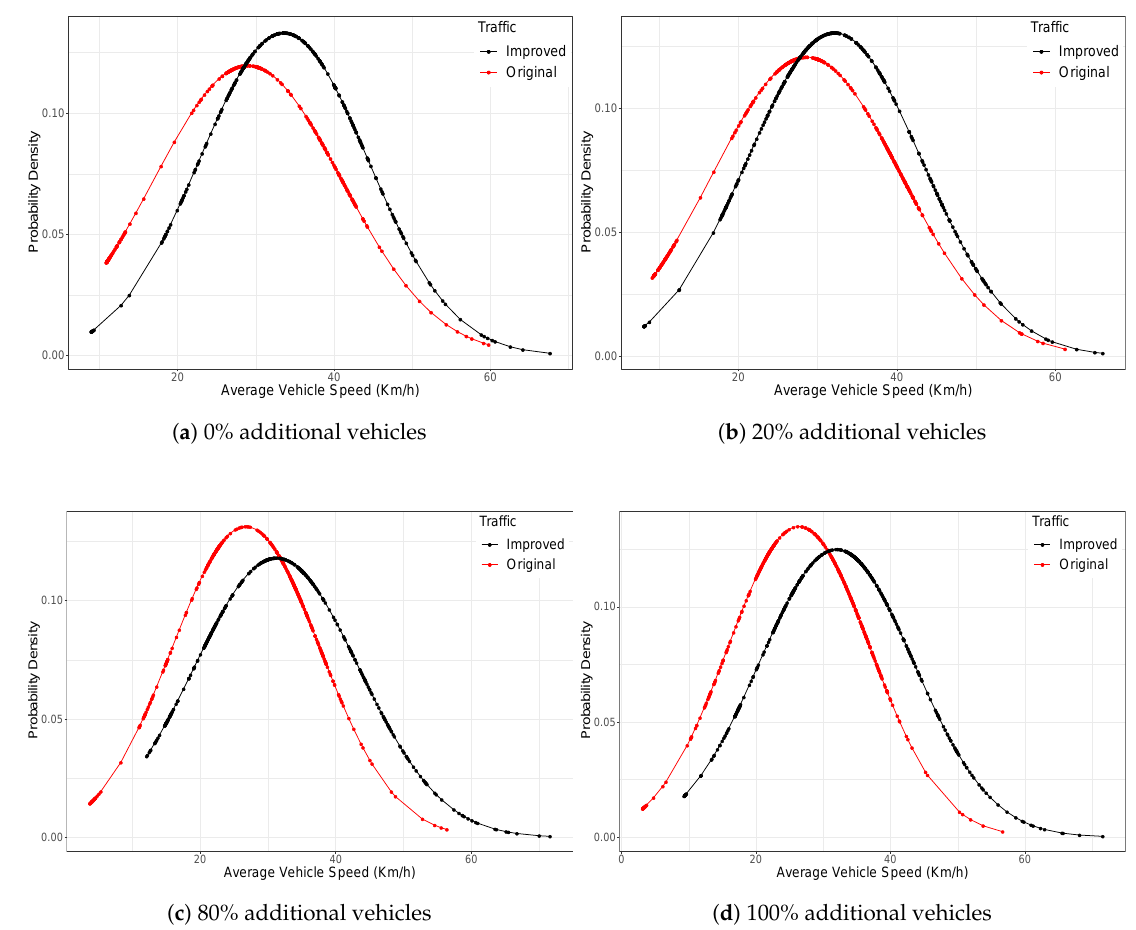
Figure 8. Average vehicle speed under different saturation